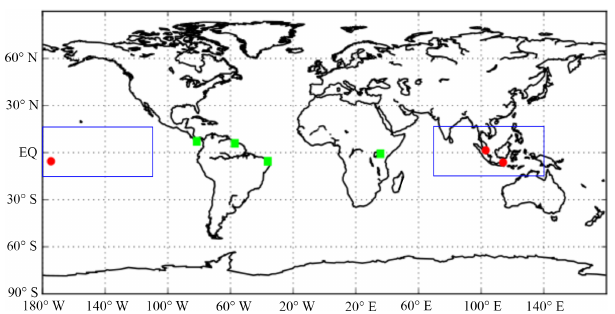
Figure 2. Map of WOUDC ozonesonde localization between 15 ◦ S and 15 ◦ N. The red circles mark ozonesonde stations between 70 ◦ E and 110 ◦ W. Green squares are ozonesonde stations elsewhere in the tropical band used hereafter. The two blue squares define the IIO region (15 ◦ S–15 ◦ N and 70–140 ◦ E) and the POC region (15 ◦ S– 15 ◦ N and 180–110 ◦ W) referred to in this